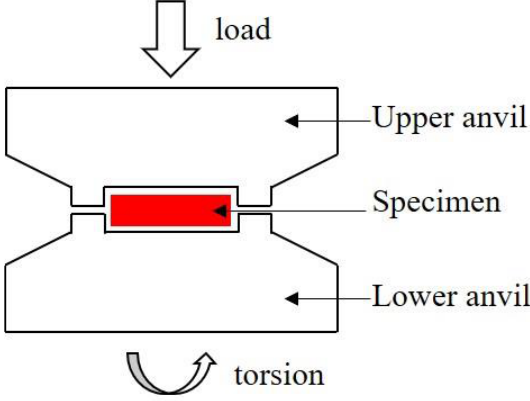
Figure 1. Schematic illustration of the HPT devices.